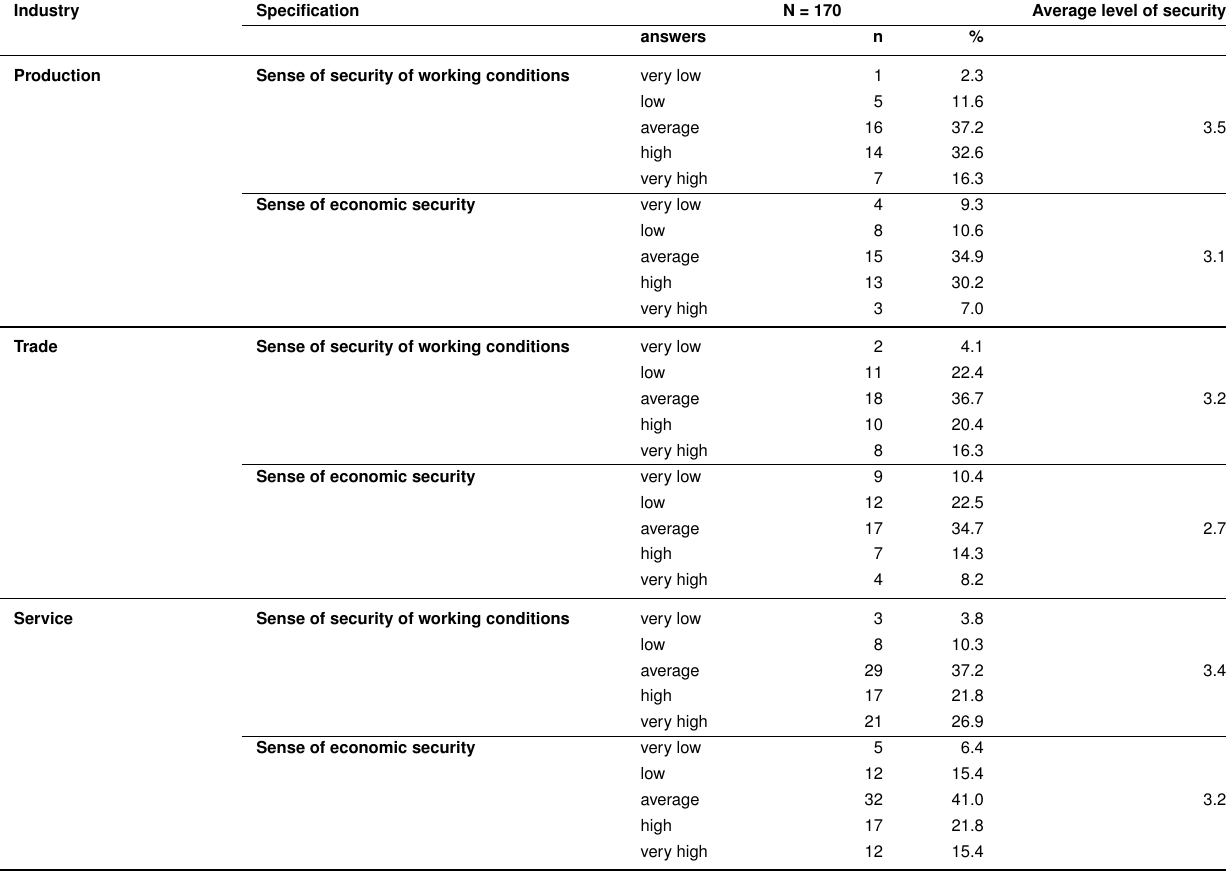
Table 3. Evaluation of the level of employee security under the conditions of the Covid-19 pandemic by trade (N = 170). Industry